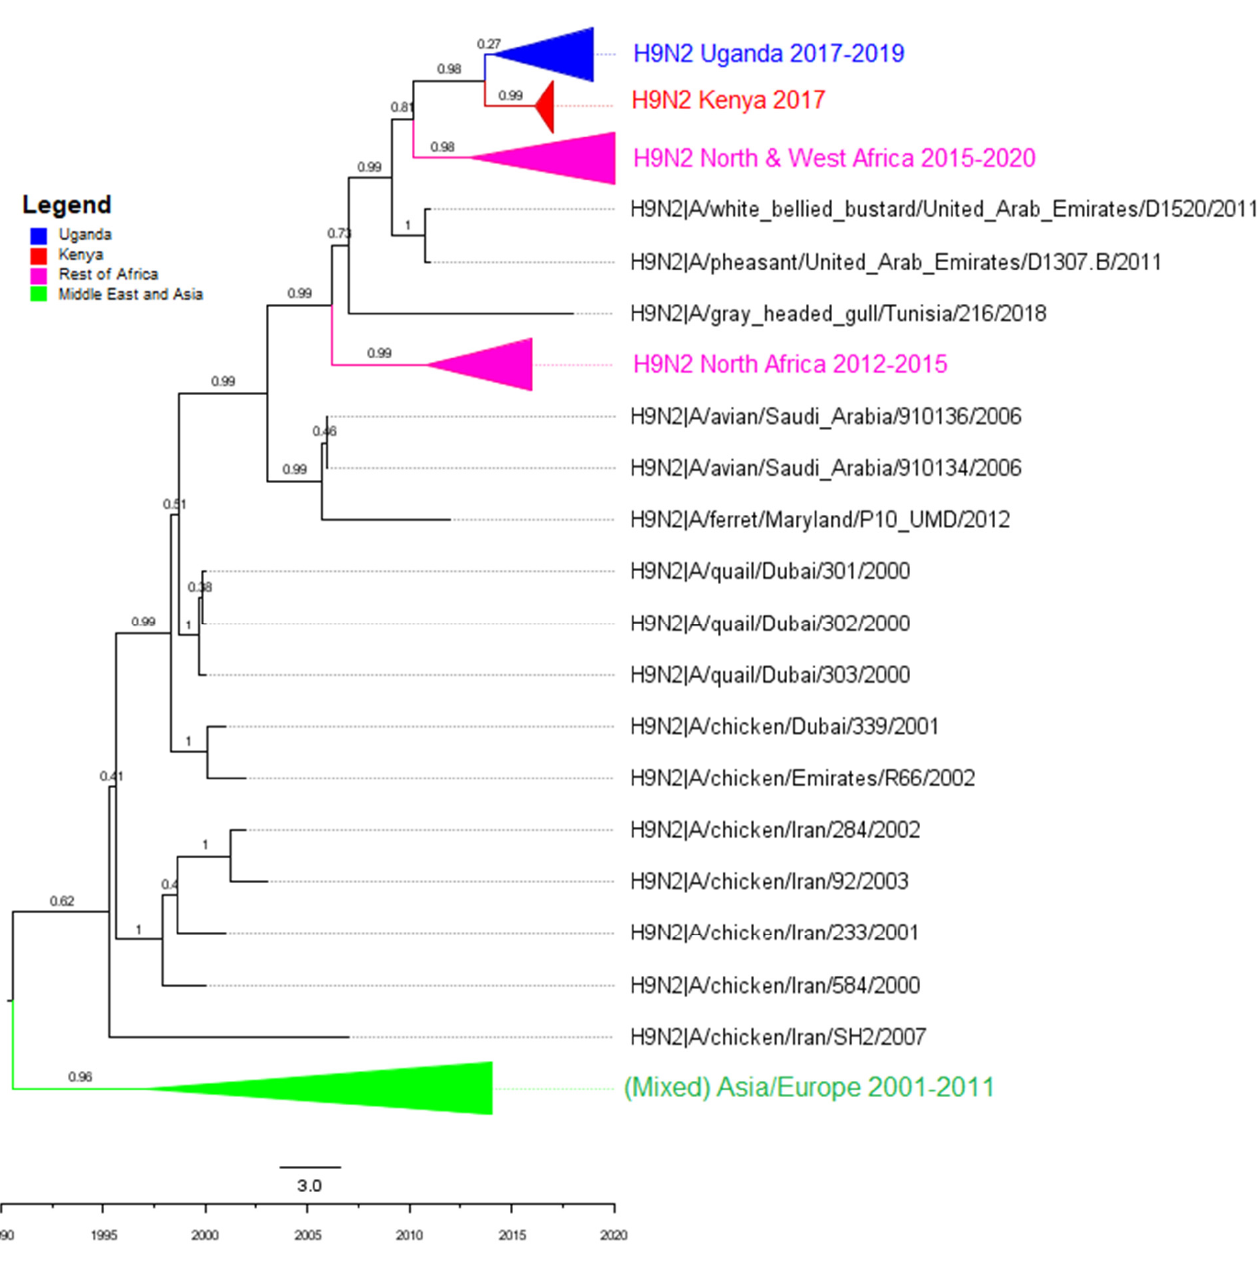
Figure A2. Phylogenetic tree for PB1. Ugandan viruses are highlighted in blue. Kenyan in red, North and West African countries in pink, and the Middle East, Asia and a few European viruses in the green clade. tMRCA for Uganda is August 2013. Posterior probabilities are shown on the branches. Scales represent substitutions and time.